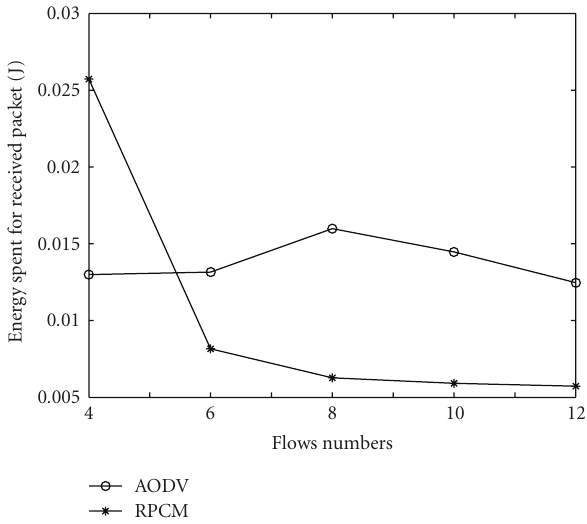
Figure 11: Performance of AODV and RPCM in terms of energy spent for received packet, when ρ = 4(nodes / m 2 ).